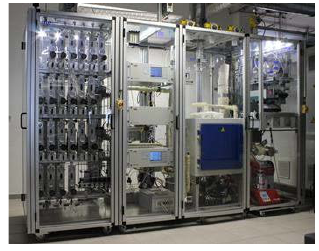
Figure 1. Environmental catalysis high-throughput (HT) testing unit.